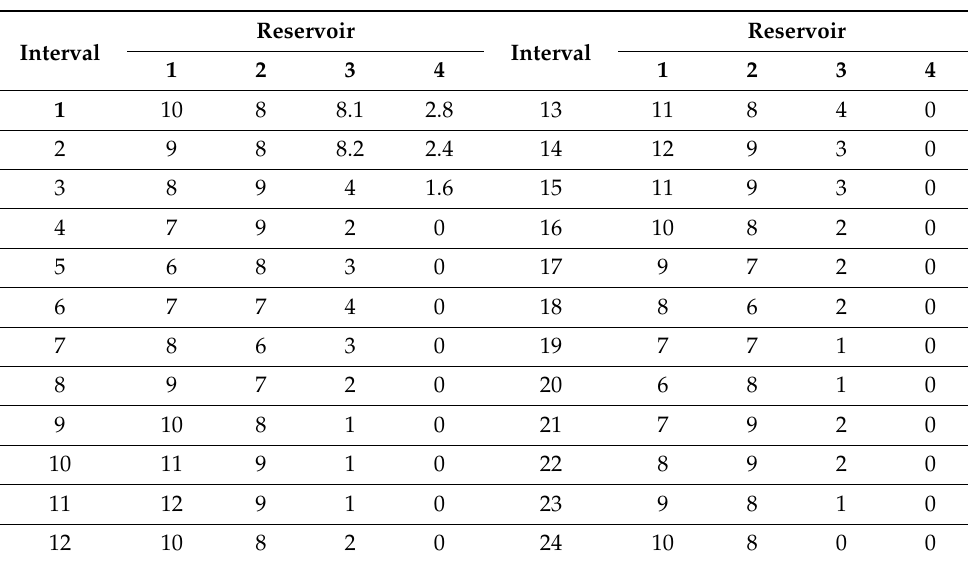
Table A3. Reservoir inflows of Test System-I and II.